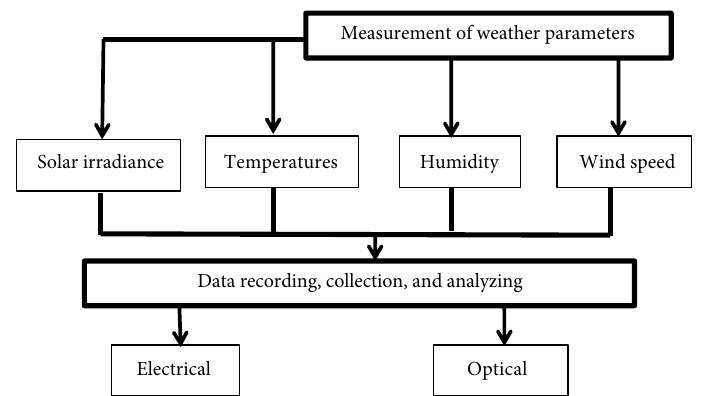
Figure 1: Conceptual framework of the